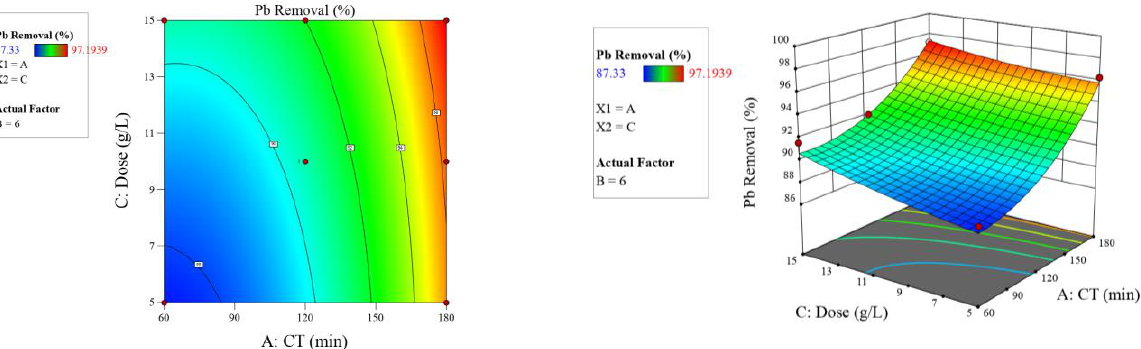
Figure 5. Two-dimensional contour and three-dimensional surface plots on the relation between contributed factors (contact time and pH) and Pb 2+ removal by Odaracha adsorbent.